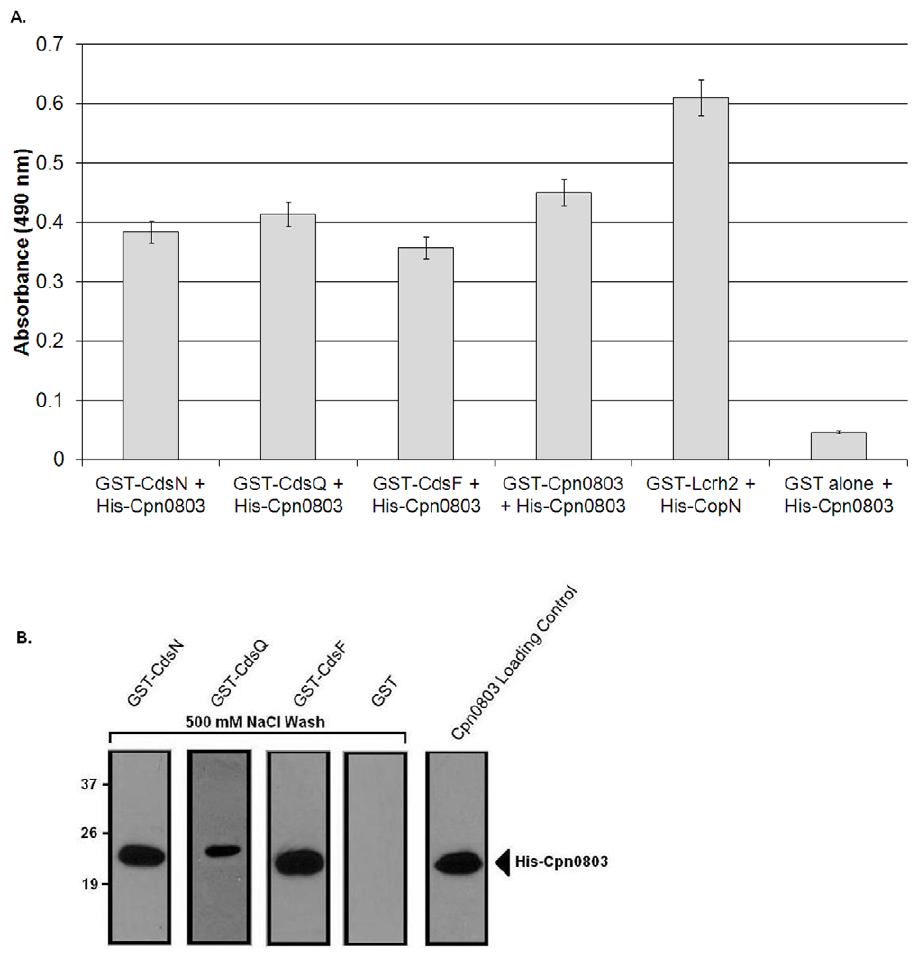
Figure 1. Cpn0803 interacts with type III secretion components invitro . A. A glutathione plate assay was applied to screen for interactions of Cpn0803 between either CdsN, CdsQ or CdsF. His-Cpn0803 was applied to GST-CdsN, -CdsQ and -CdsF immobilized on glutathione plates, washed three times with PBS, and monitored using a colorimetric assay. Data is represented on the graph as the mean 6 standard deviation for each interaction. A significant interaction was considered to be two standard deviations above the negative control (GST alone against Cpn0803). As a positive control, we screened GST-Cpn0803 against His-Cpn0803, as well as GST-Lcrh-2 against His-CopN. Cpn0803 interacted significantly with CdsN, CdsQ, CdsF, and Cpn0803. while it did not interact with GST alone. GST-Lcrh-2 and His-CopN also had a significant interaction. B. We applied GST pull- down assays to corroborate the interactions found with the glutathione plate assay. GST-CdsN, -CdsQ, –CdsF or GST alone immobilized on glutathione beads were incubated with an E. coli lysate over-expressing His-Cpn0803 and washed with 500 mM NaCl. GST-CdsN, -CdsQ, and CdsF co- purified with Cpn0803 under 500 mM NaCl conditions while GST alone did not.